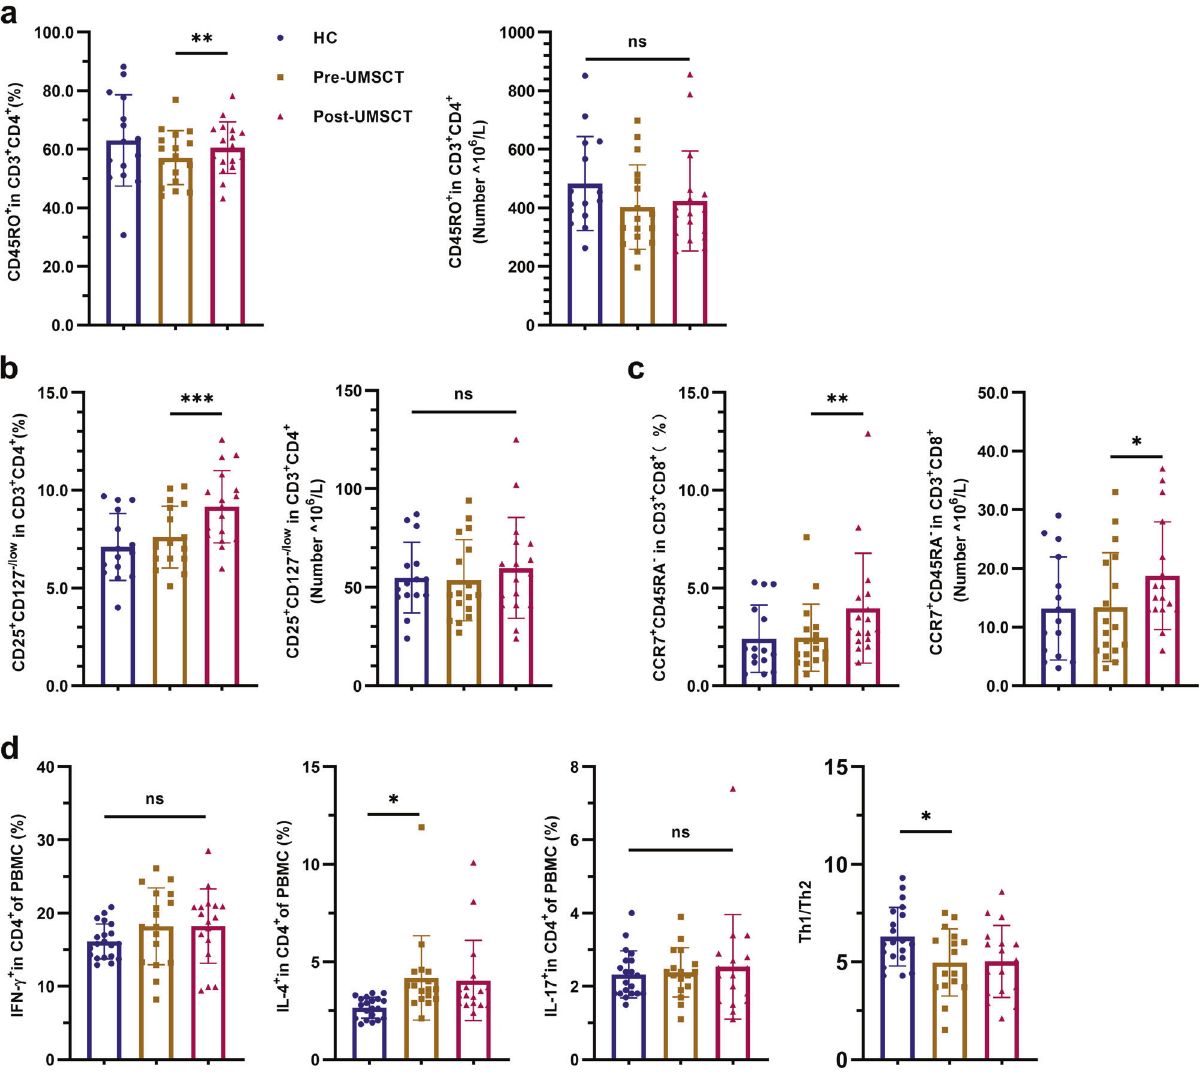
Fig. 4 Frequencies and numbers of T lymphocyte subsets in PB of HC and patients with psoriasis pre- and post-UMSCT. a Frequencies and numbers of CD4 + memory T cells (CD45RO + in CD3 + CD4 + ). b Frequencies and numbers of Tregs (CD25 + CD127 - /low in CD3 + CD4 + ). c Frequencies and numbers of CD8 + TCM cells (CCR7 + CD45RA - in CD3 + CD8 + ). (HC, n = 15; Patients, n = 17; ns, no signi fi cant, VS HC; * P < 0.05, ** P < 0.01, *** P < 0.001 VS Pre-UMSCT); d Frequencies of Th1, Th2, Th17 and the ratio of Th1/Th2. (HC, n = 15; Patients, n = 17; * P < 0.05, VS HC; ns, no signi fi cant, VS